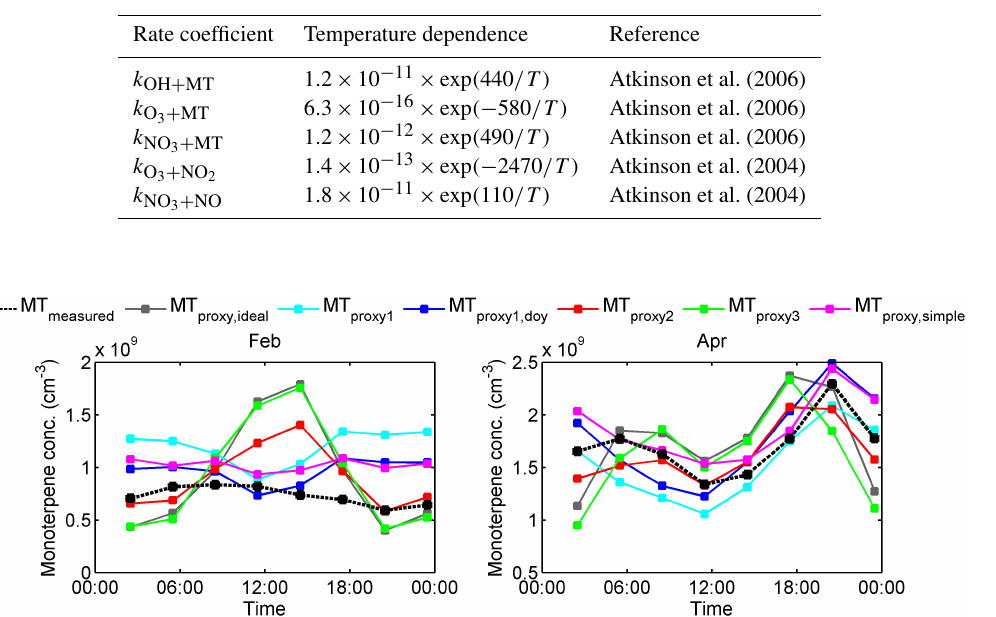
Atmos. Chem. Phys., 16, 13291–13307,